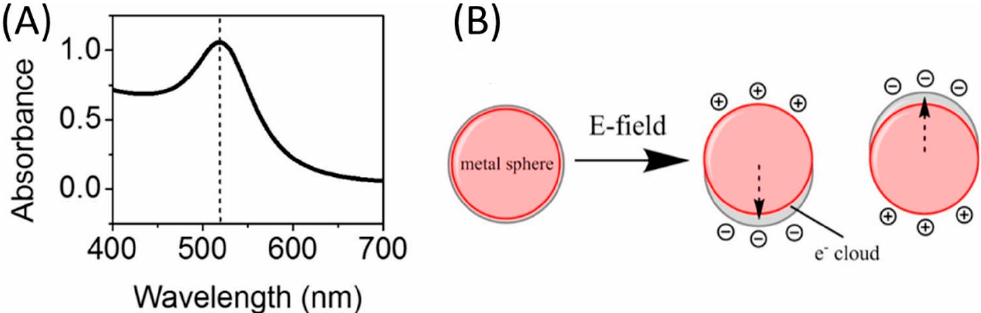
Figure 2. The schematic illustration of ( A ) UV spectrum of 13 nm AuNPs colloid system and ( B ) the oscillation of conduction electrons across the AuNPs in the electromagnetic field of the incident light.